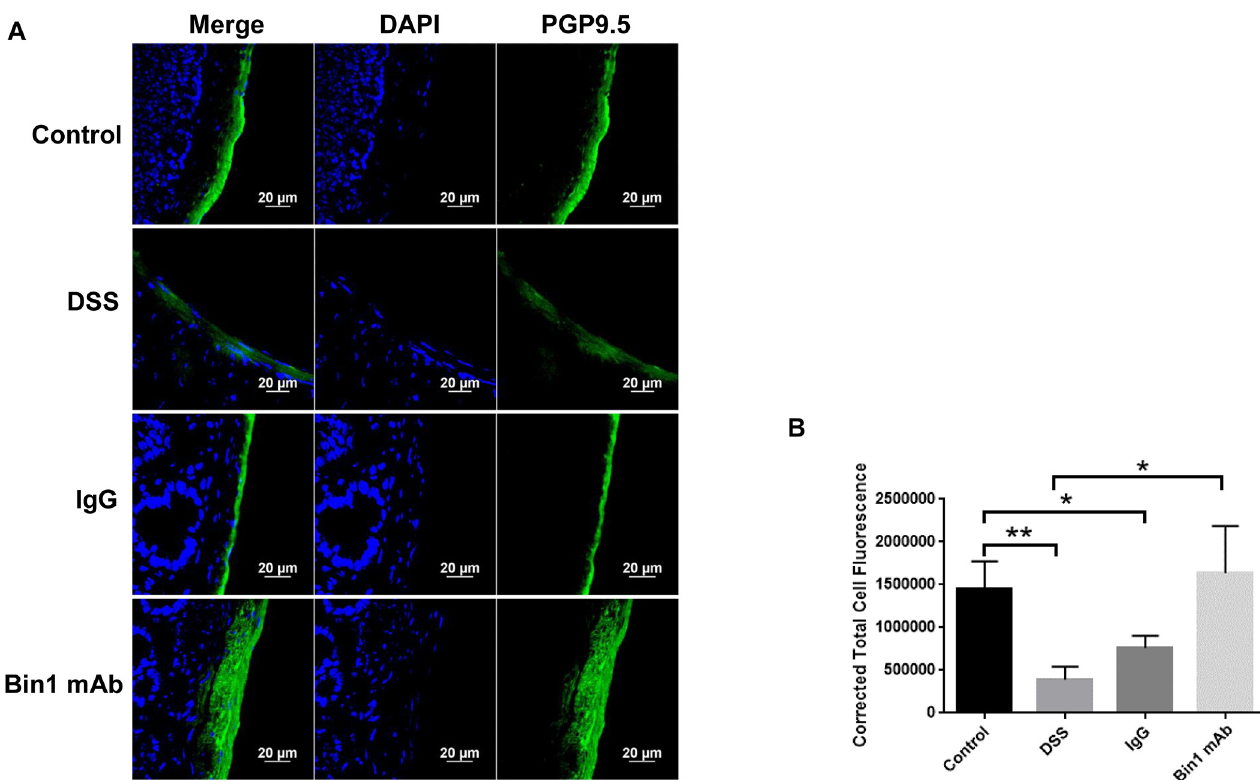
Fig 4. Treatment with Bin1 mAb improved PGP9.5 expressing enteric neurons after DSS-induced colitis. Fig 4A . Effect of Bin1 mAb treatment on the expression of PGP9.5 neuronal cells in the colon of DSS-induced colitis mice as determined by confocal microscopy. Representative image from two independent experiments shown. Fig 4B . Bin1 mAb treated mice had high levels of PGP9.5 expressing neuronal cells in the muscularis of the colon as quantitated by CTCF analysis (CTCF analysis, n = 3 mice tissues per treatment) ( � P < 0.05, �� P < 0.01, as determined by t test). Control and DSS � p < 0.0063, Control and IgG � p < 0.0259, DSS and Bin1 mAb � p <